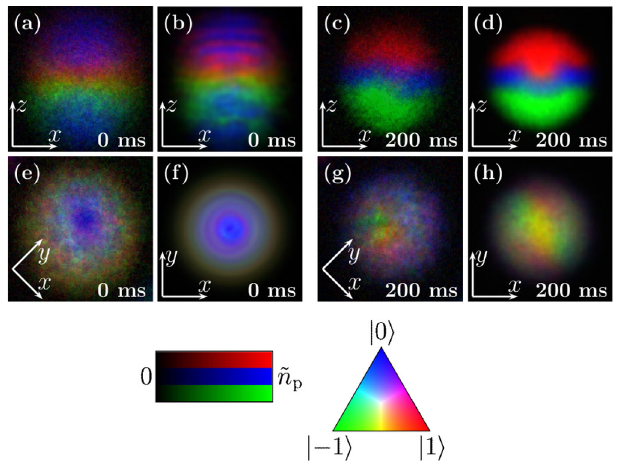
FIG. 2. Column particle densities in the three − z -quantized spin states for (a,b,e,f) the isolated monopole and (c,d,g,h) the dynamically formed Dirac monopole. The experimental data and the corresponding simulation results are shown in panels (a,c,e,g) and (b,d,f,h), respectively. The hold times are indicated in the bottom-right corner of each panel. The quadru- 4 . 3 G = cm. The peak particle density is pole field gradient is b q ¼ ~ n 8 . 5 × 10 8 cm − 2 for the images along y in (a – d) and ~ n p ¼ p ¼ 1 . 0 × 10 9 cm − 2 for the images along z in (e – h). The field of view in each panel is 228 × 228 μ m 2 .